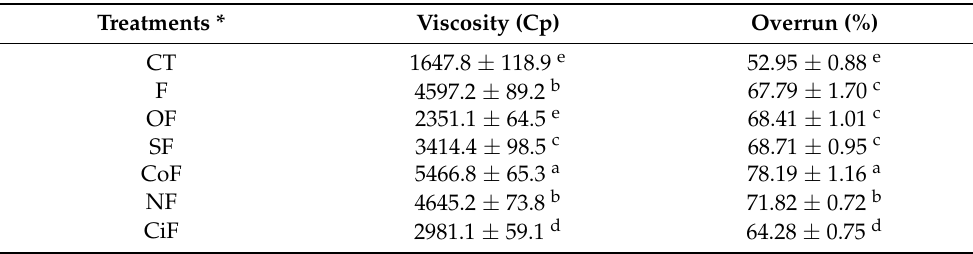
Table 2. Physical properties of frozen yoghurt as affected by using chufa milk and different flavoring materials (Mean ± SE of 3 replicates).